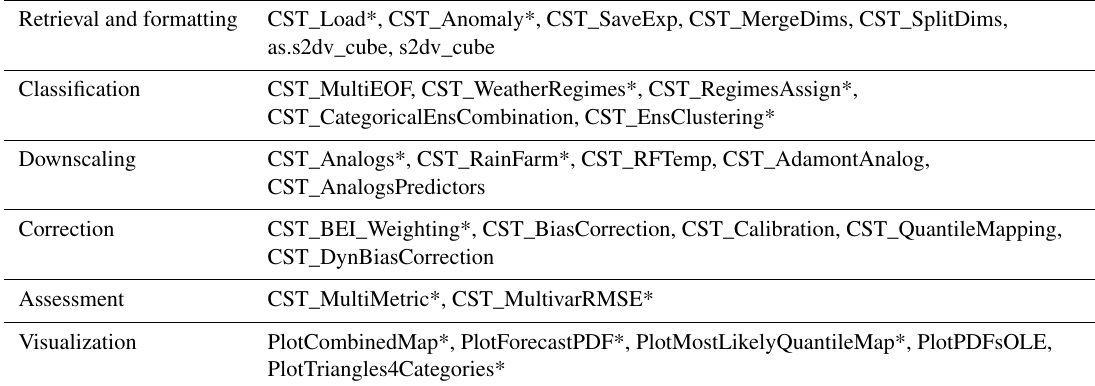
Table 1. Summary of the functions and methods by category included in CSTools. The prefix CST_ refers to functions working on a specific object class called s2dv_cube, while those without the prefix accept multi-dimensional arrays with named dimensions as input. Asterisks indicate functions that are used in vignettes (see Appendix B for a detailed